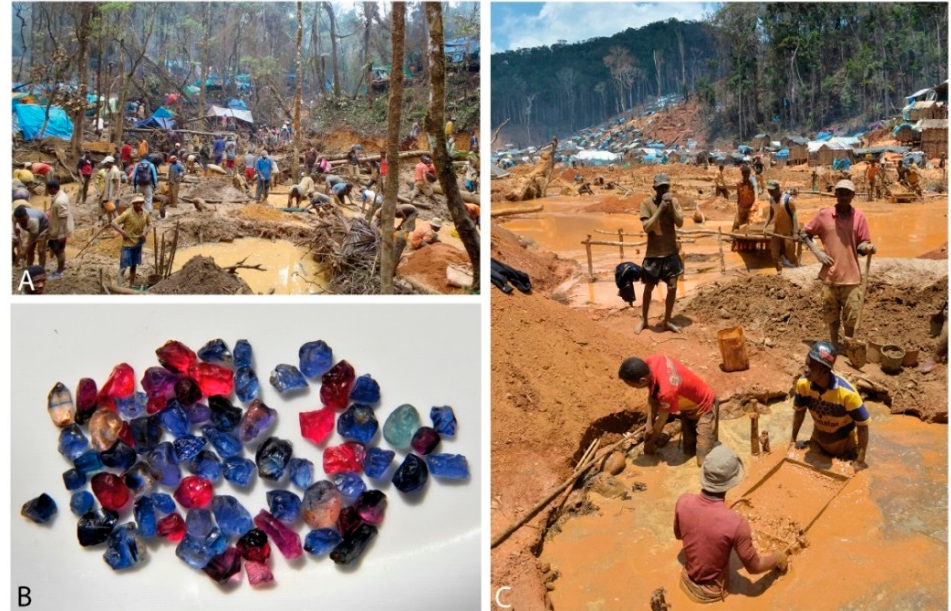
Figure 59. Placer deposits in the eastern part of Madagascar. ( A ) General view of the ruby and sapphire deposit in the jungle of Didy. Photo: Nirina Rakotosaona; ( B ) crystals of ruby and sapphires from the Didy deposit. The crystals are around 8 mm in size; photo: Vincent Pardieu © GIA; and ( C ) sapphire and pink corundum placer deposits in the jungle near Bemainty. Photo: Vincent Pardieu. Ruby is generally associated with sapphires at Vatomandry [77,78], Didy [265] (Figure 59), and